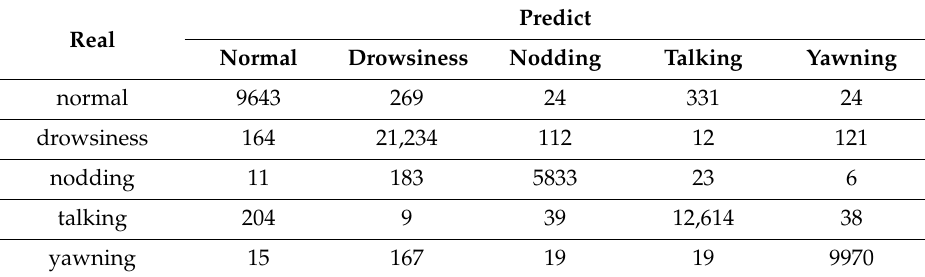
Table 3. Drowsiness detection details for di ff erent states of the NTHU-DDD dataset in GFDN. Real